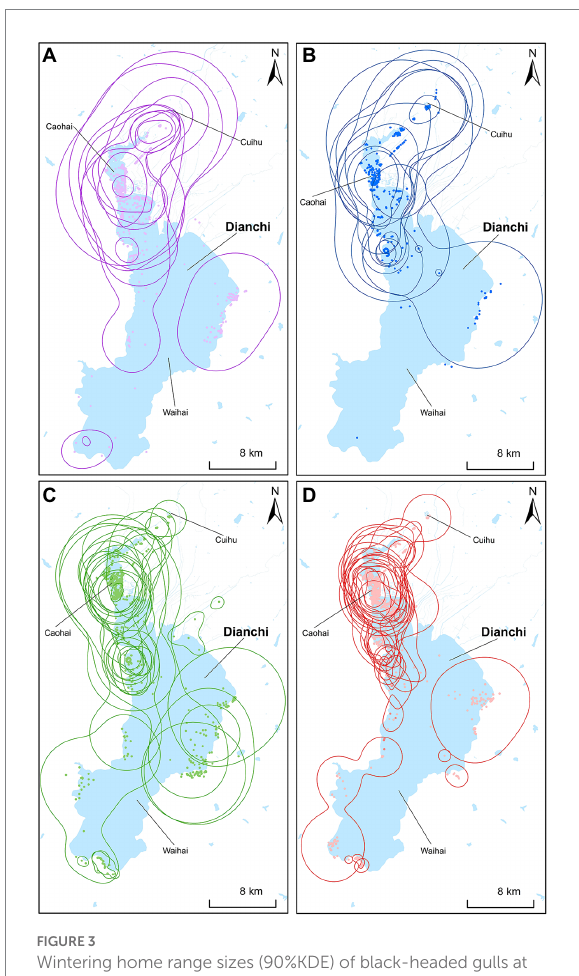
FIGURE 3 Wintering home range sizes (90%KDE) of black-headed gulls at different stages in Dianchi Lake, Kunming City, Yunnan Province, southwestern China. ( A -SOP2019, n = 11; B -SCP2019, n = 11; C - SOP2020, n = 20; D -SCP2020, n =